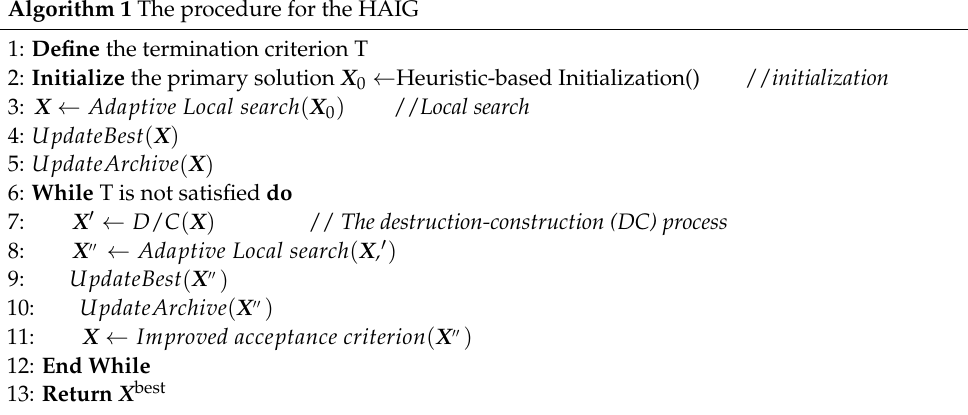
Algorithm 1 The procedure for the